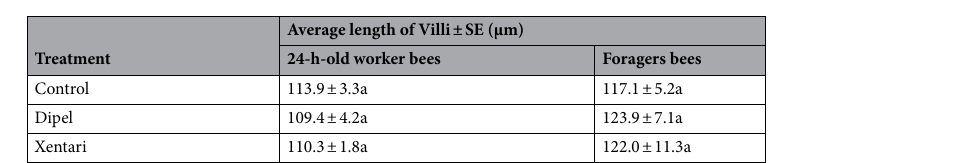
Figure 4. Path taken by Apis mellifera bees at 24 h after ingestion of Candi paste incorporated with the indicated products. ( A ) A. mellifera newly emerged worker bees (control); ( B ) A. mellifera newly emerged worker bees (Dipel); ( C ) A. mellifera newly emerged worker bees (Xentari); ( D ) A. mellifera foragers worker (control); ( E ) A. mellifera foragers worker (Dipel); ( F ) A. mellifera foragers worker (Xentari).